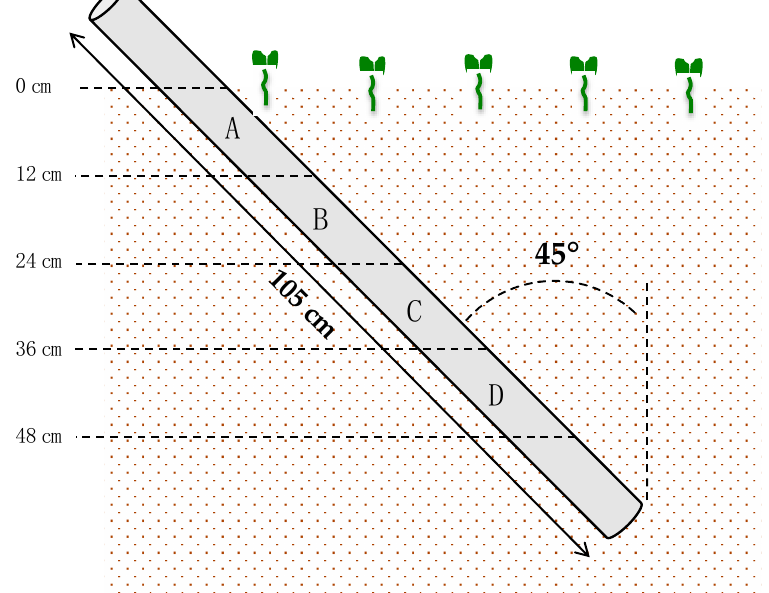
Figure 1. Minirhizotron positioning in soil. Transparent tubes (105 cm length, 7 cm diameter) were inserted at 45° angle with a manual auger. Four observation zones were defined: A (0–12 cm), B (12– 24 cm), C (24–36 cm) and D (36–48 cm).